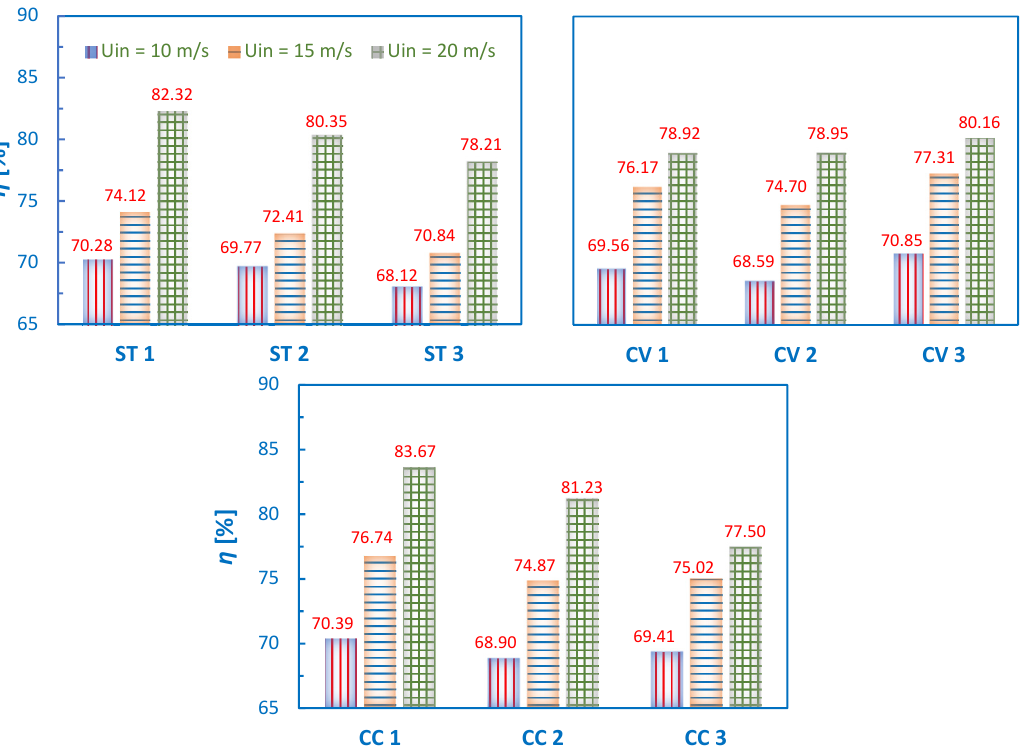
Figure 10. Overall separation efficiency in all the cyclone models of ST variant, CV variant and CC variant at inlet velocities U in = 10, 15 and 20 m/s.